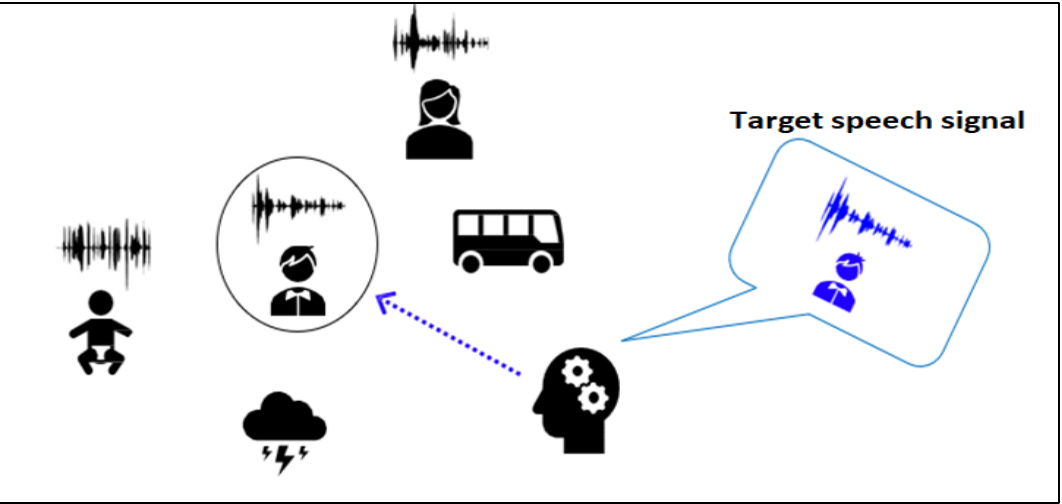
Figure 1. Humans can focus on the target speech signal in a crowded and noisy environment [6].